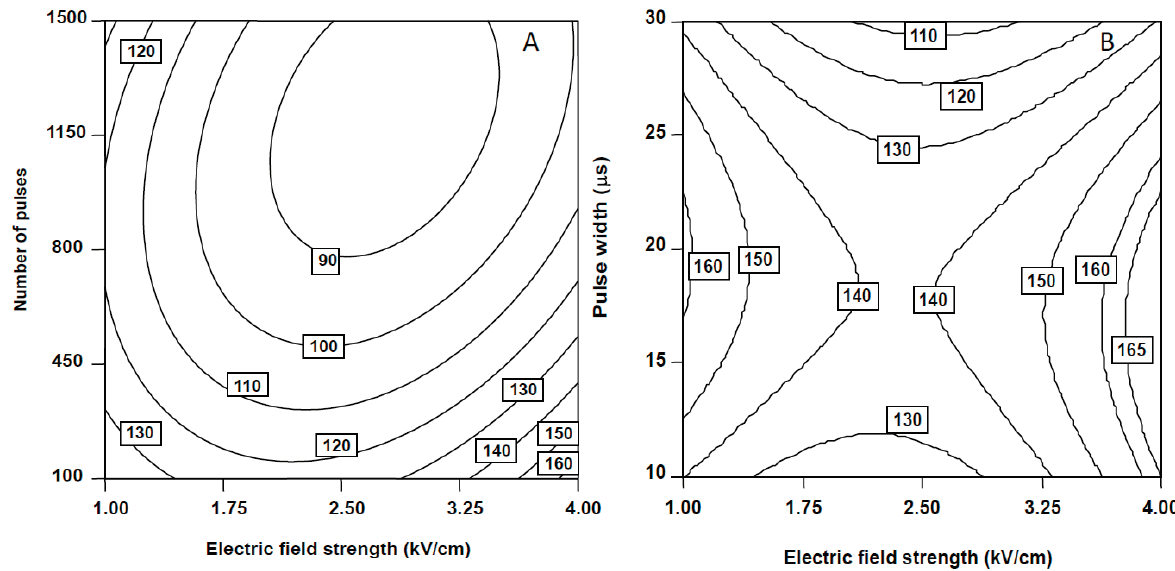
Figure 2. Counter plots for the combined effect of the number of pulses and electric field strength ( A ) and the combined effect of pulse width and electric field strength ( B ) on FaDOH relative content of carrot slices. (A) Pulse frequency set at 10 Hz and pulse width set at 10 μ s. (B) Pulse frequency set at 10 Hz and number of pulses set at